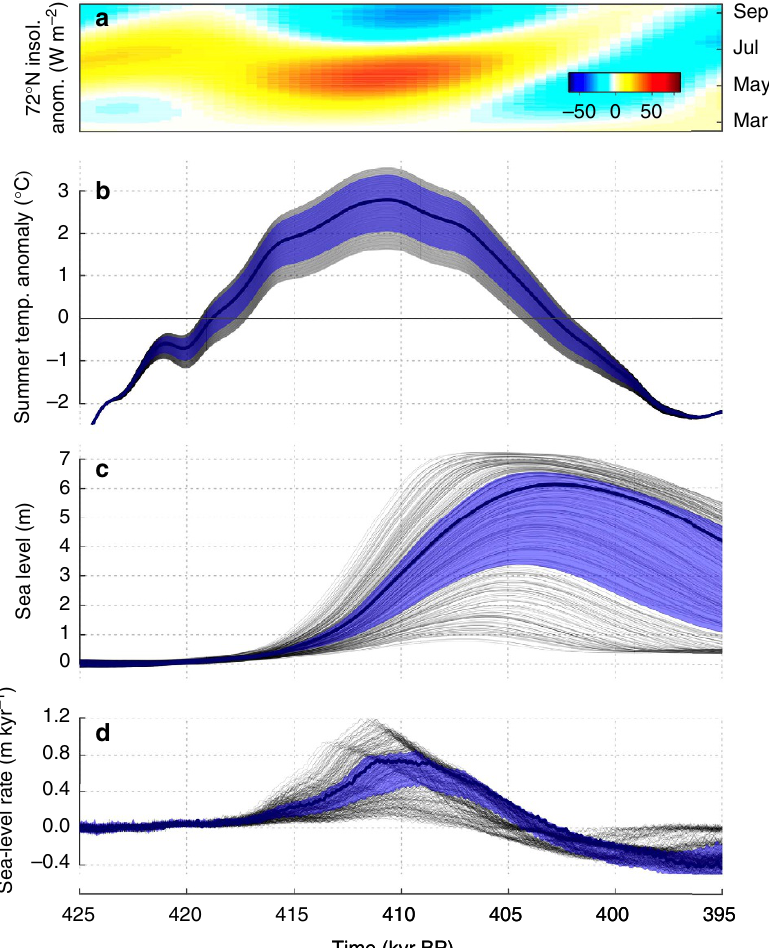
Figure 1 | MIS-11 time series. Insolation anomaly (Wm (cid:2) 2 ) for March-September at 72 (cid:2) N ( a ) and regional summer (JJA) temperature anomaly ( (cid:2) C) forcing ( b ) relative to present day, simulated sea-level equivalent volume loss (m s.l.e.) of the Greenland ice sheet ( c ) and simulated rate of sea-level contribution (m per kyr) ( d ). In b – d , the grey lines show the individual simulations, while the shaded blue band and thick blue line indicate the constrained 95% credible interval and the most likely simulation, respectively.